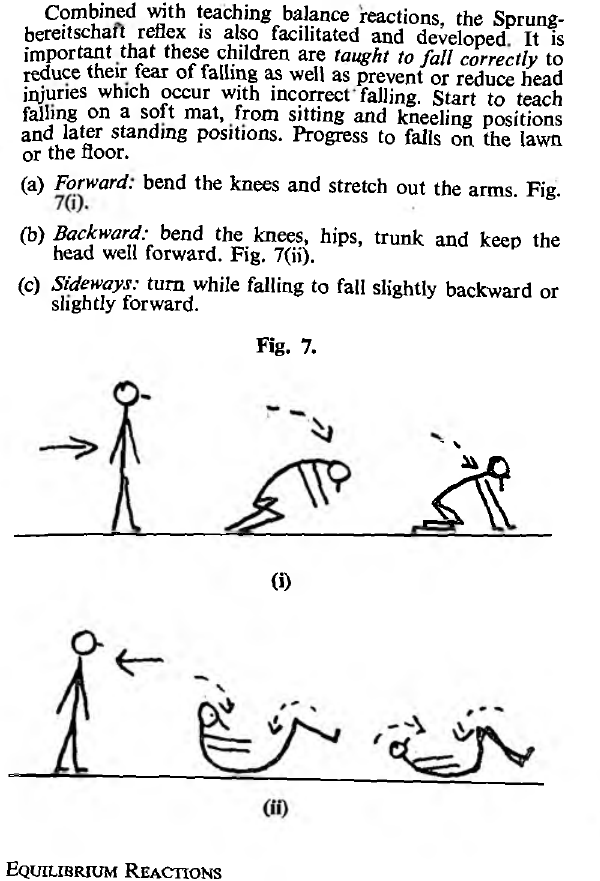
(i) Sitting on a table.